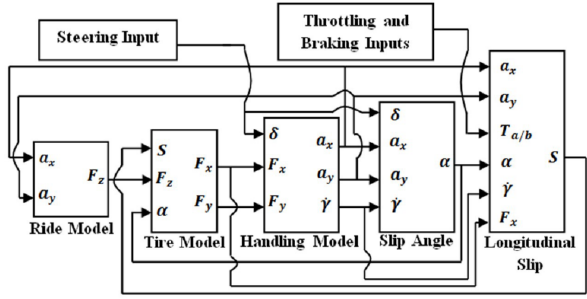
Figure 1: Flow chart of model-based vehicle dynamics framework in